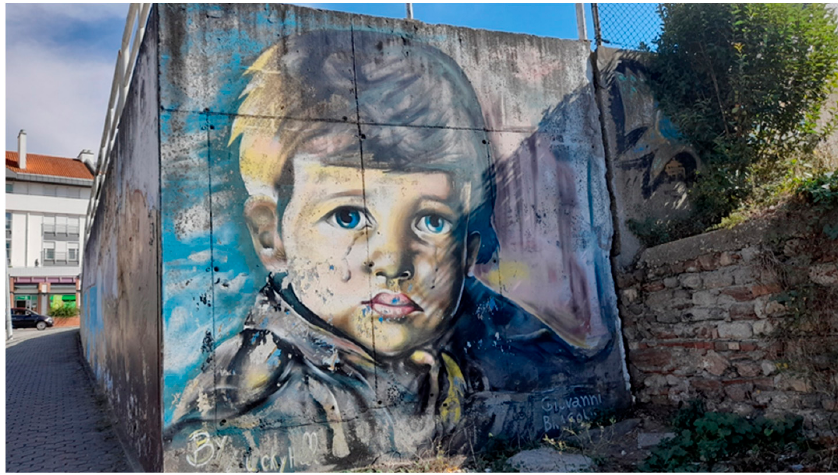
Figure 2. “The Crying Boy” by Lucky Hell, 2016 (Source: author’s own photo, 2022). Revisiting “The Crying Boy” that day felt like a journey to the past, to the memory of that haunting, anguished look. To my children, I explained that during the 1970s and 1980s, nearly every Portuguese home had a replica of a painting that, in truth, puzzled and scared all of us, even those who were unaware of the multitude of myths and urban legends associated with it. We had one in the corridor, right in front of my bedroom door, and, most times, I averted my gaze from it. They found the deco trend equal parts strange and amusing and wanted to learn more about what it was like to grow up in those years. Shortly after, I found myself taking a walk down memory lane and describing my childhood, telling them about other trends and people’s views, habits and traditions back then in the aftermath of a 40-year fascist dictatorship. ultimately constitute my identity as well as that of an entire generation of individuals.